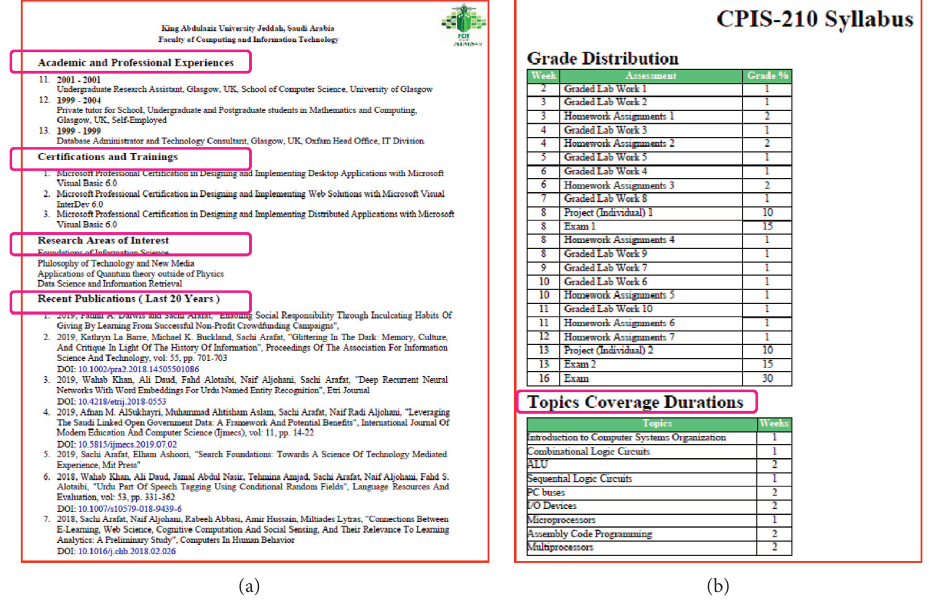
Figure 2: Captured criteria that support the